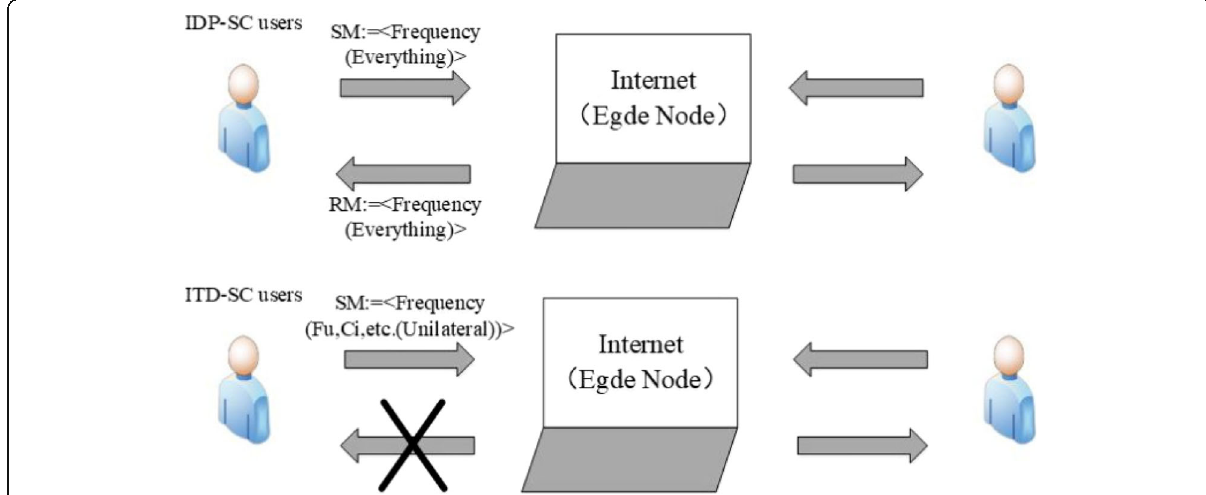
Fig. 6 Model for determining user